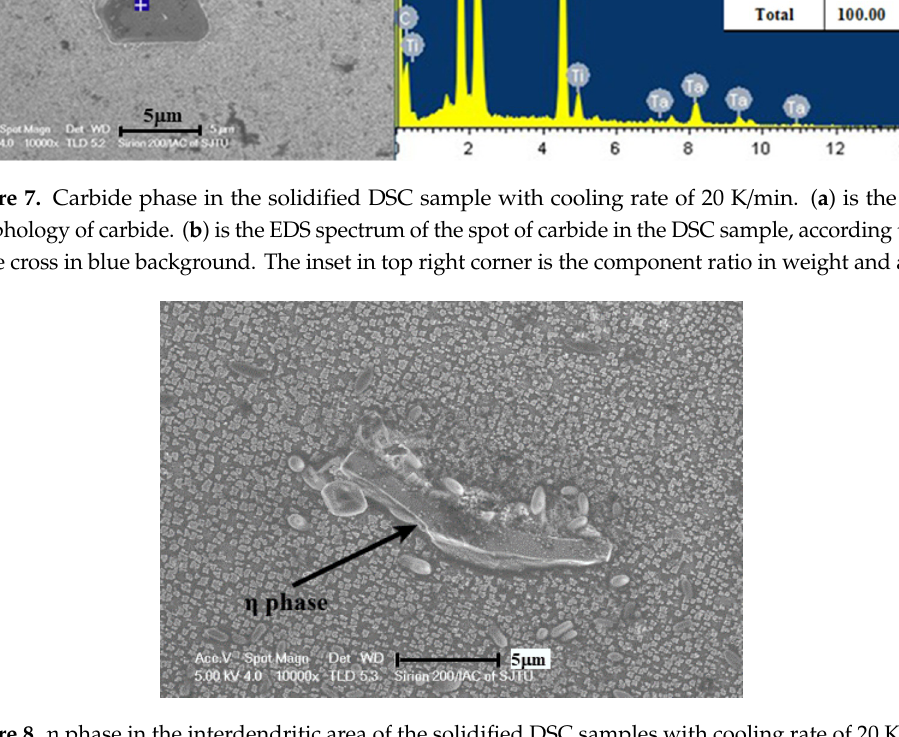
Figure 8. η phase in the interdendritic area of the solidified DSC samples with cooling rate of 20 K/min.